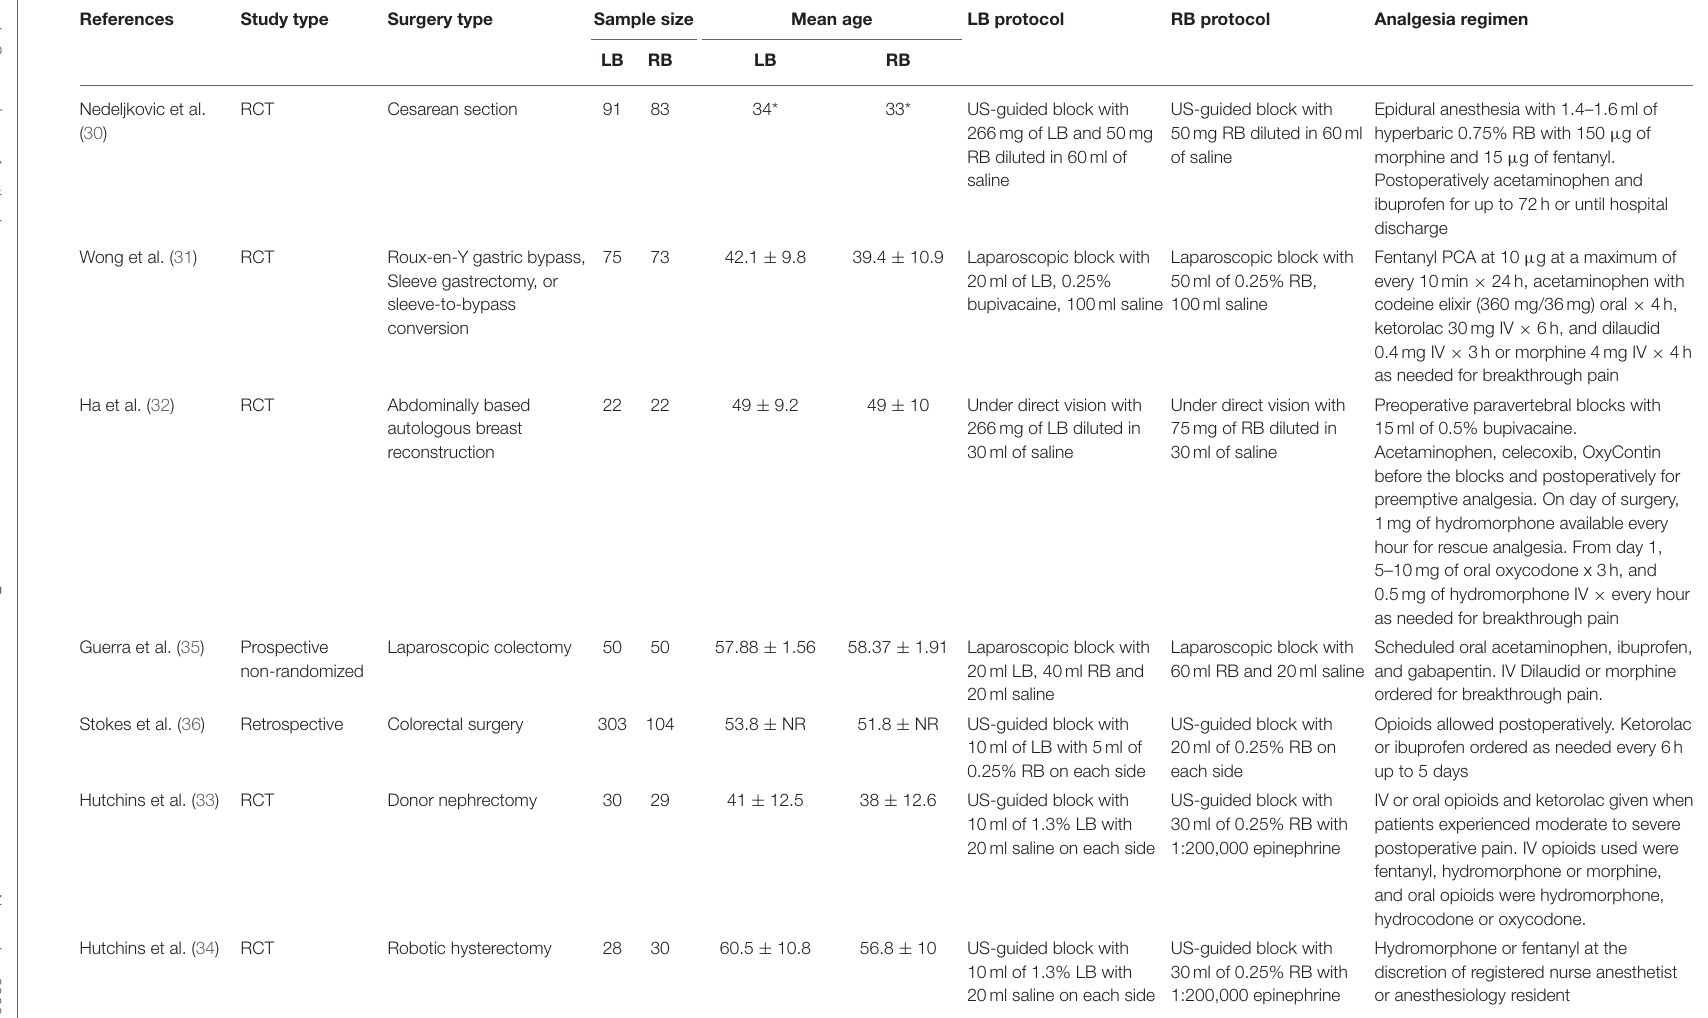
TABLE 2 | Characteristics of included